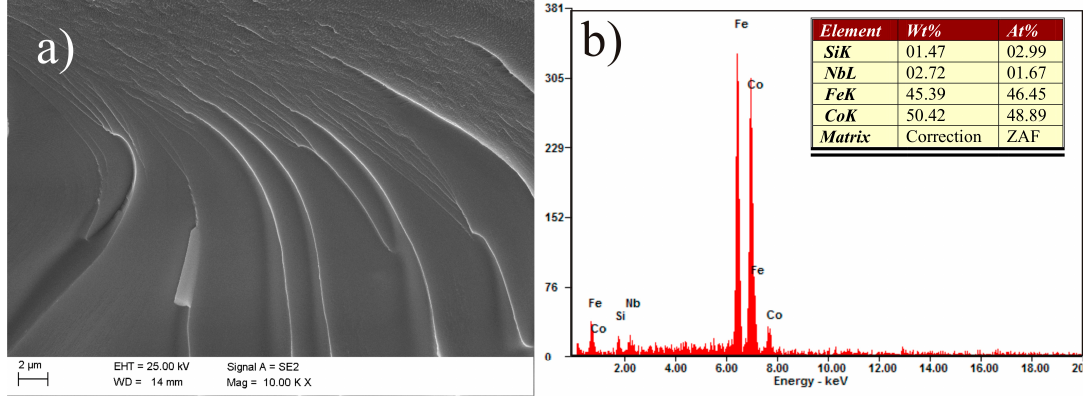
Figure 5. Scanning electron microscopy (SEM) micrographs of the fracture morphology of Fe 36.00 Co 36.00 B 19.00 Si 5 Nb 4 ribbon with the thickness of 0.07 mm: ( a ) view; ( b ) Energy-dispersive X-ray spectroscope (EDS) spectrum from area in ( a ).